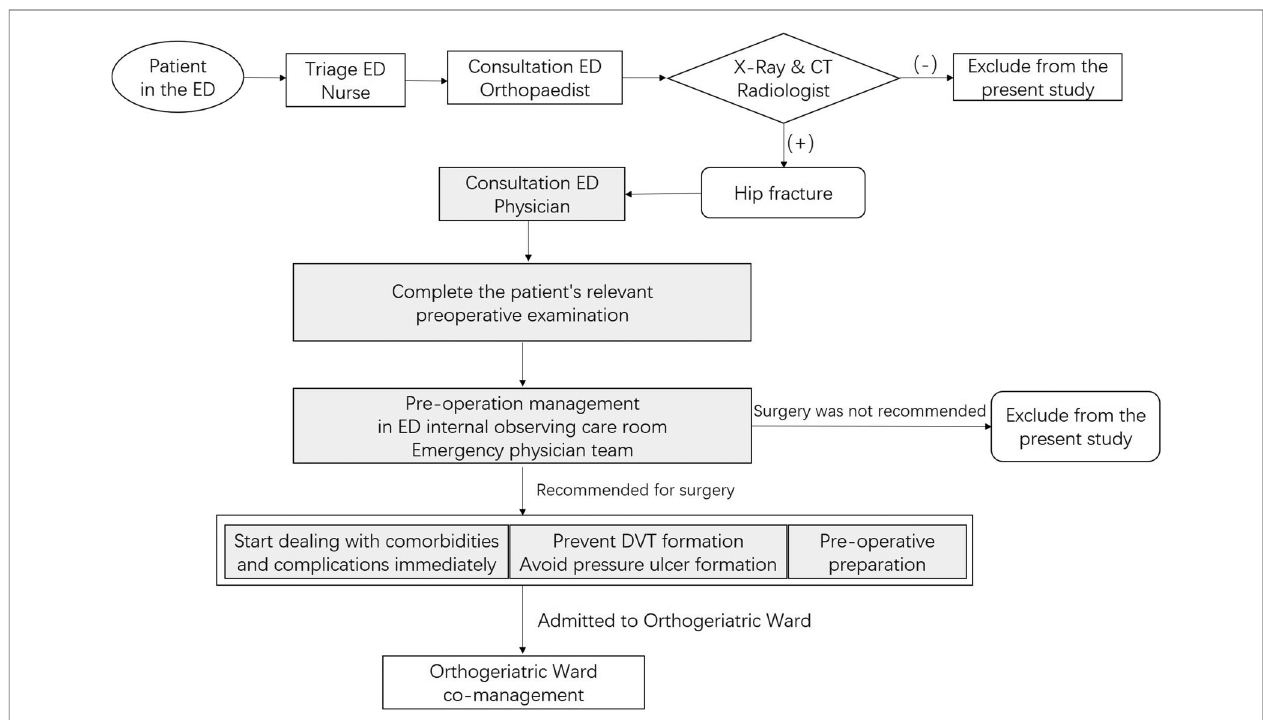
FIGURE 2 | Flow chart of operation mode of intervention